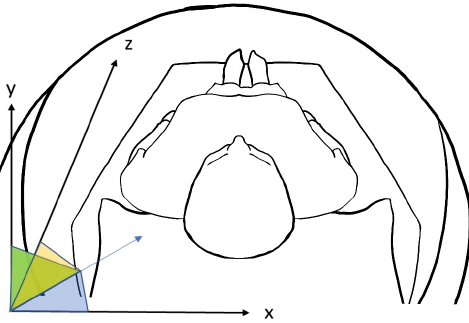
Figure 3. Spatial orientation of x, y and z axis of styloid process. Comparing the styloid major axis to the orthogonal CT reference, the software calculates: - Angle on x-axis: the angle between the styloid major axis and the x-axis. Visually, it is the direction from lateral to medial. The bigger this angle, the lesser the medial direction of the styloid bone. - Angle on y-axis: the angle between the styloid major axis and the y-axis. Visually, it is the direction from back to nose. The bigger this angle, the lesser the anterior direction of the styloid bone. - Angle on z-axis: the angle between the styloid major axis and the z-axis. Visually, it is the direction from head to feet. The bigger this angle, lesser the inferior direction of the styloid bone.